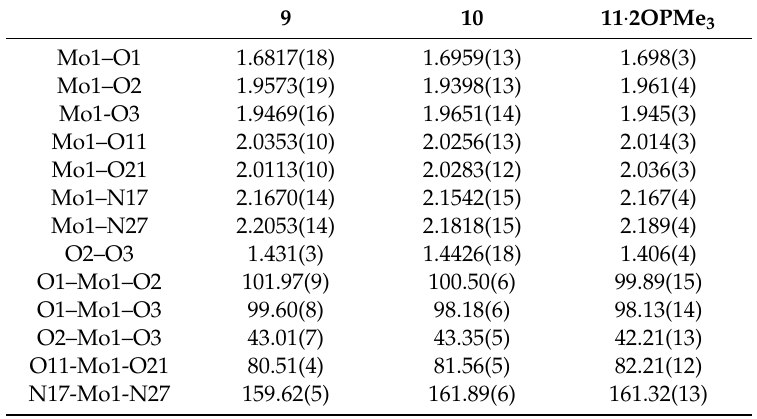
Table 2. Selected bond lengths (Å) and angles ( ◦ ) for the oxido peroxido molybdenum(VI) complexes 9 , 10 and 11 · 2OPMe